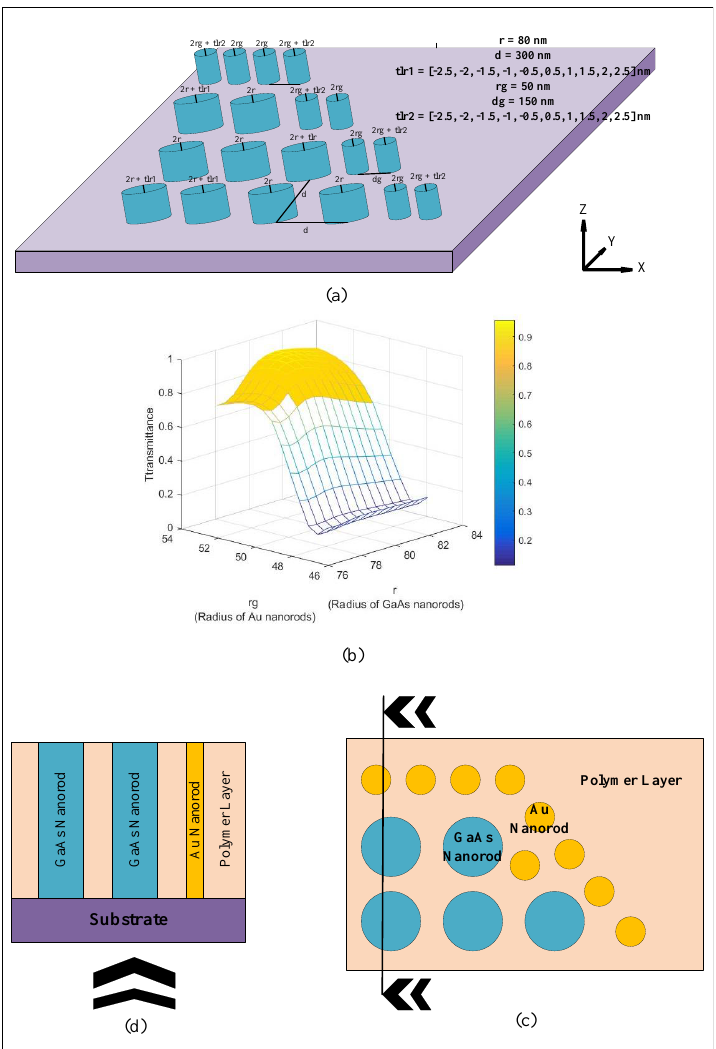
Figure 15. ( a ) Design and schematic of the proposed structure with radius random tolerance of Au and GaAs nanorods performed simultaneously. ( b ) The transmittance in terms of the average radius of GaAs and Au nanorods is depicted simultaneously. ( c ) A part of the proposed structure consisting of polymer layer and GaAs and Au nanorods. ( d ) Schematic of the polymer layer and GaAs and Au nanorods placed together